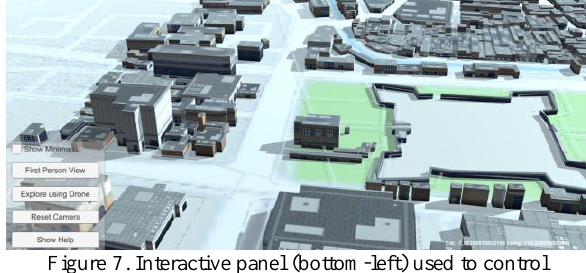
Figure 7. Interactive panel (bottom-left) used to control interactivity in Unity Game